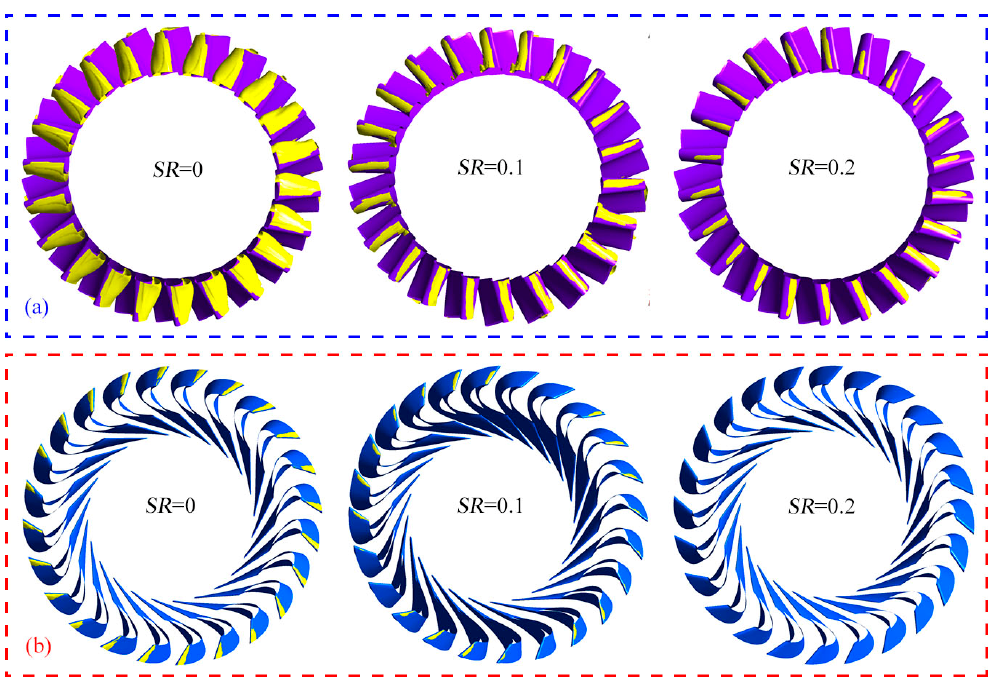
Figure 10. Isosurface of 0.1 vapor volume fraction distribution in the stator and turbine domains under various SRs . ( a ) cavitation distribution in stator at different SR s, ( b ) cavitation distribution in turbine at different SR s.